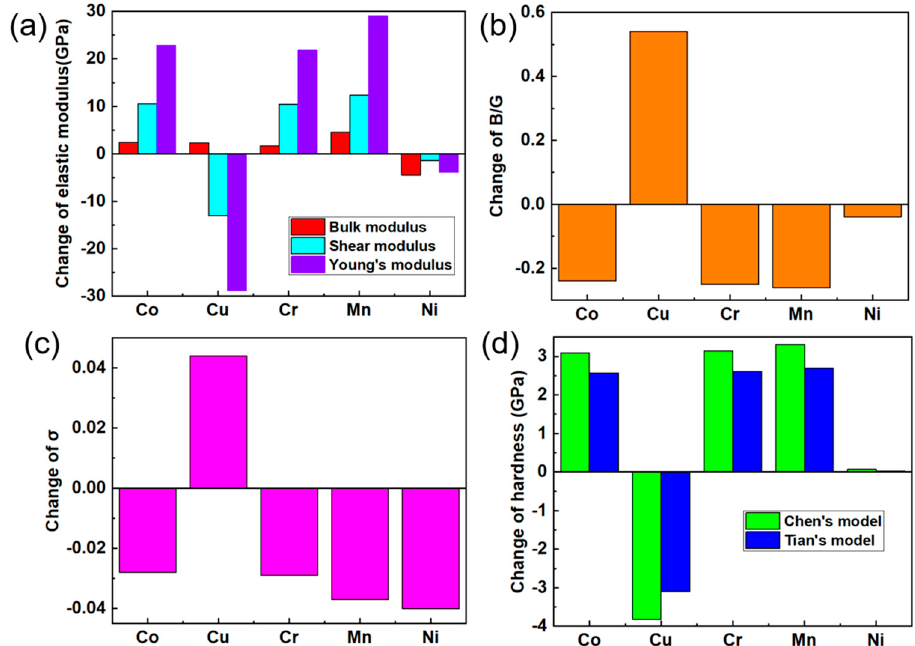
Figure 5. The multialloying effect on the mechanical properties of Al 13 (Fe,M) 4 phases with different alloying elements doping; ( a ) the bulk, shear, and Young’s modulus; ( b ) the B / G ; ( c ) the Poisson’s ratio ( σ ); ( d ) the intrinsic hardness based on Tian and Chen model. It must be noted that Al 13 Fe 4 is set as the reference and all relative values are taken with respect to those of the Al 13 Fe 4 phase. Additionally, the negative values refer to the decrease in the properties of interest upon the addition of alloying elements to Al 13 Fe 4 . Table 5. Bulk modulus, shear modulus, Young’s modulus, Poisson’s ratio, B / G , and intrinsic hardness of Al 13 (Fe,M) 4 phases with different elements doping, and the unit is